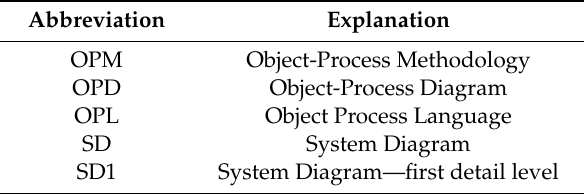
Table 1. Abbreviations used for Object-Process Methodology—OPM